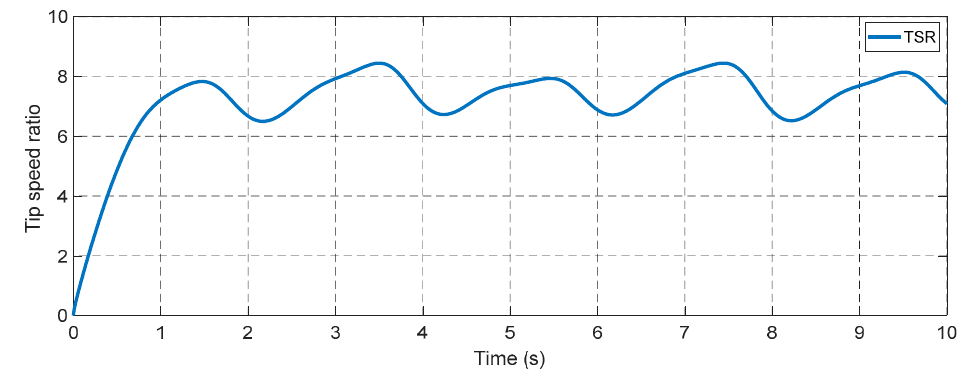
Figure 15. Tip speed ratio.